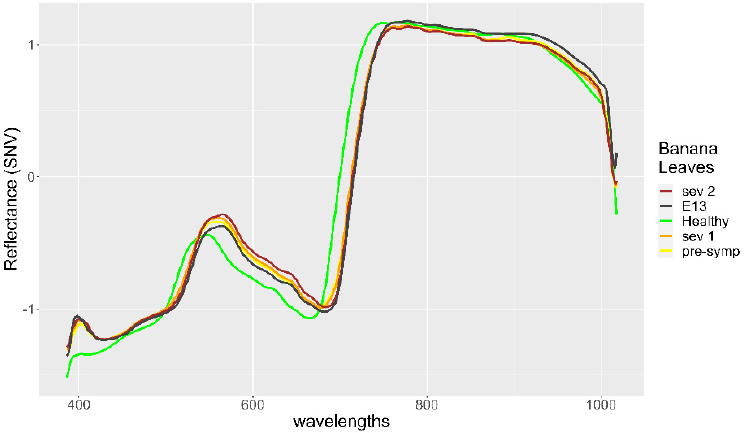
Figure 4. Spectral signature of 13th Leaf (E13 dark green color) compared with the spectral signature of healthy banana leaves and infected banana leaves.